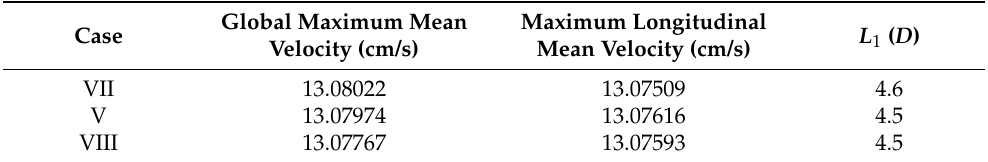
Table 3. Some results of cases V, VII, and VIII for grid independence validation, where L 1 is defined in Section 3.